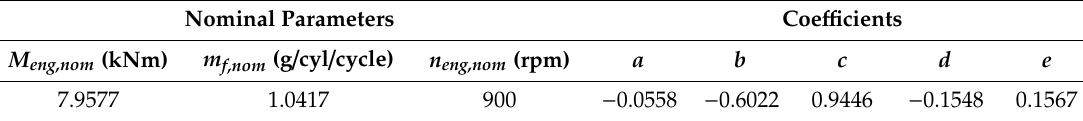
Table A3. Coe ffi cients of engine torque model of auxiliary engine.